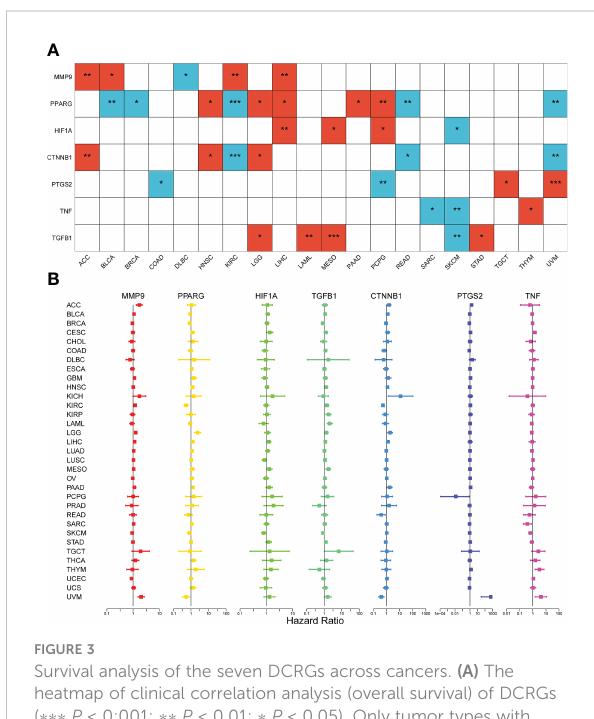
FIGURE 3 Survival analysis of the seven DCRGs across cancers. (A) The heatmap of clinical correlation analysis (overall survival) of DCRGs ( ∗∗∗ P < 0:001; ∗∗ P < 0.01; ∗ P < 0.05). Only tumor types with statistical signi fi cance are shown. The red square indicates high gene expression is associated with a worse prognosis; the blue square indicates low gene expression is associated with a worse prognosis. (B) Cox proportional hazard analyses illustrate the hazard ratios (HRs) of the seven DCRGs in 33 TCGA tumors. DCRGs with HR > 1 were regarded as risk factors, while DCRGs with HR < 1 were regarded as protective